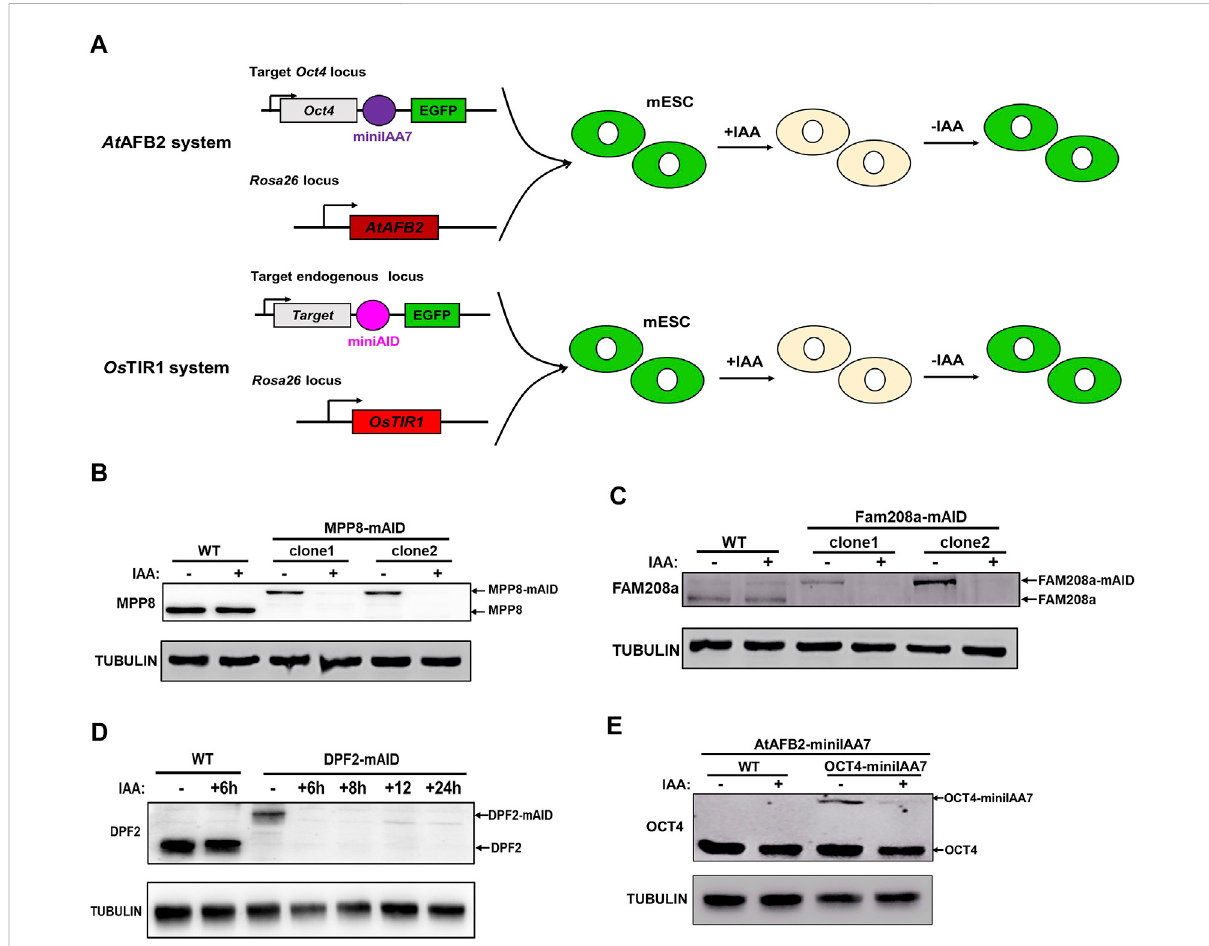
FIGURE 1 Targeting Oct4 , Mpp8 , Fam208a and Dpf2 genes with At AFB2-miniIAA7 and Os TIR1-miniAID systems in mESCs. (A) Experimental scheme to generate Rosa26- At AFB2:Oct4-miniIAA7-eGFP and Rosa26- Os TIR1:Target gene-miniAID-eGFP ESCs; Immunoblot detection of MPP8-mAID (B) , Fam208a-mAID (C) and DPF2-mAID (D) protein expression. Treatment with 500 µM of IAA for about 24 h degraded the mAID fused proteins. (E) Western blotting analysis showed the degradation of Oct4-miniIAA7 protein in the presence of IAA inducer. The Rosa26- At AFB2:Oct4- miniIAA7-eGFPcellsandWTparentalcellsweretreatedwithDMSOand500 µMofIAArespectivelyfor24 hbeforeWesternblotwithanti-OCT4and anti-TUBULIN